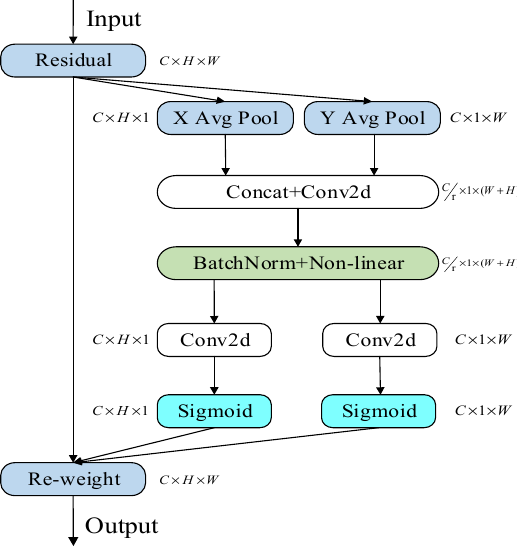
Figure 10. Coordinate attention